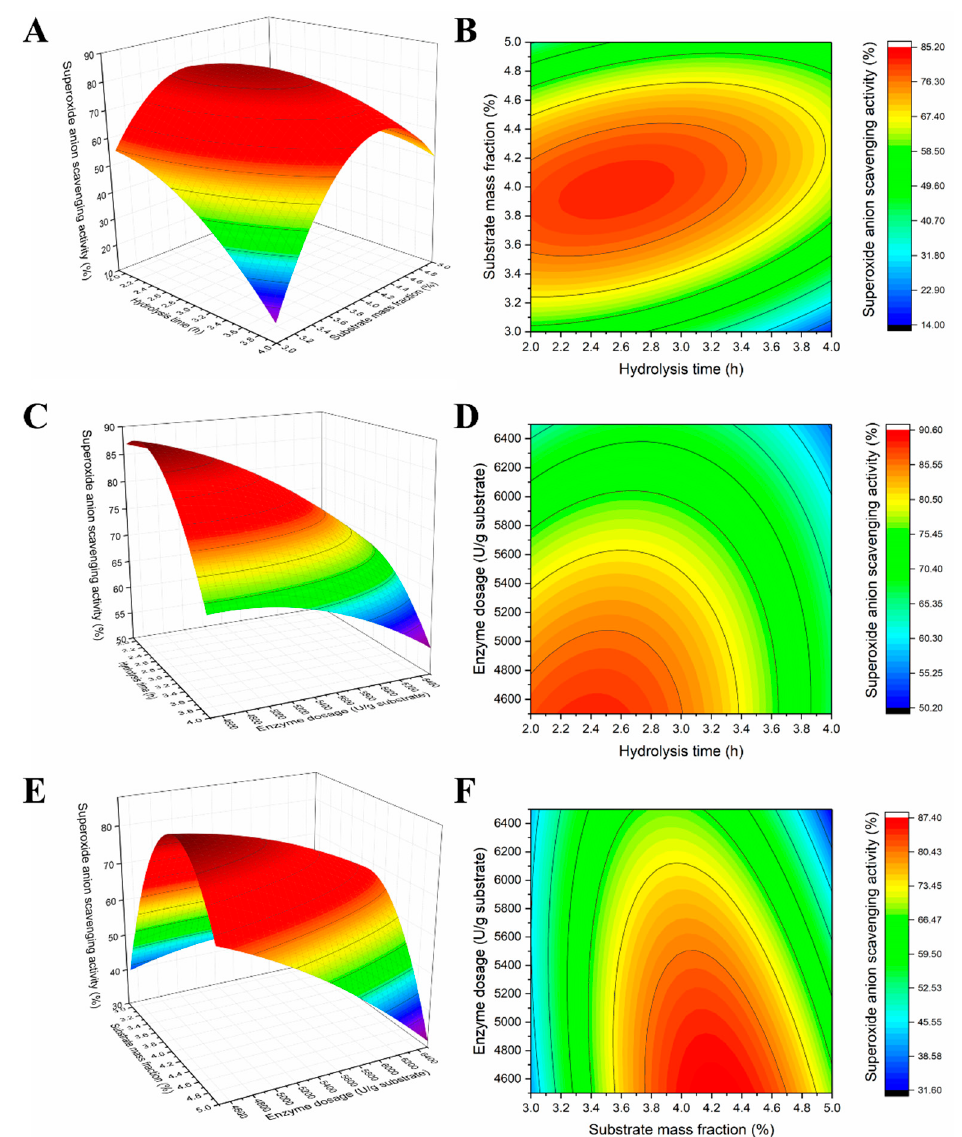
Figure 1. Response surface (3D) and contour plots (2D) showed that the effects of different hydrolysis parameters (X 1 : Hydrolysis time; X 2 : Substrate mass fraction; X 3 : Enzyme dosage) on the O 2 − scavenging activity. (( A , B ) indicated the effect of X 1 and X2, ( C , D ) indicated the effect of X 1 and X 3 , ( E , F ) indicated the effect of X 2 and X 3 ).